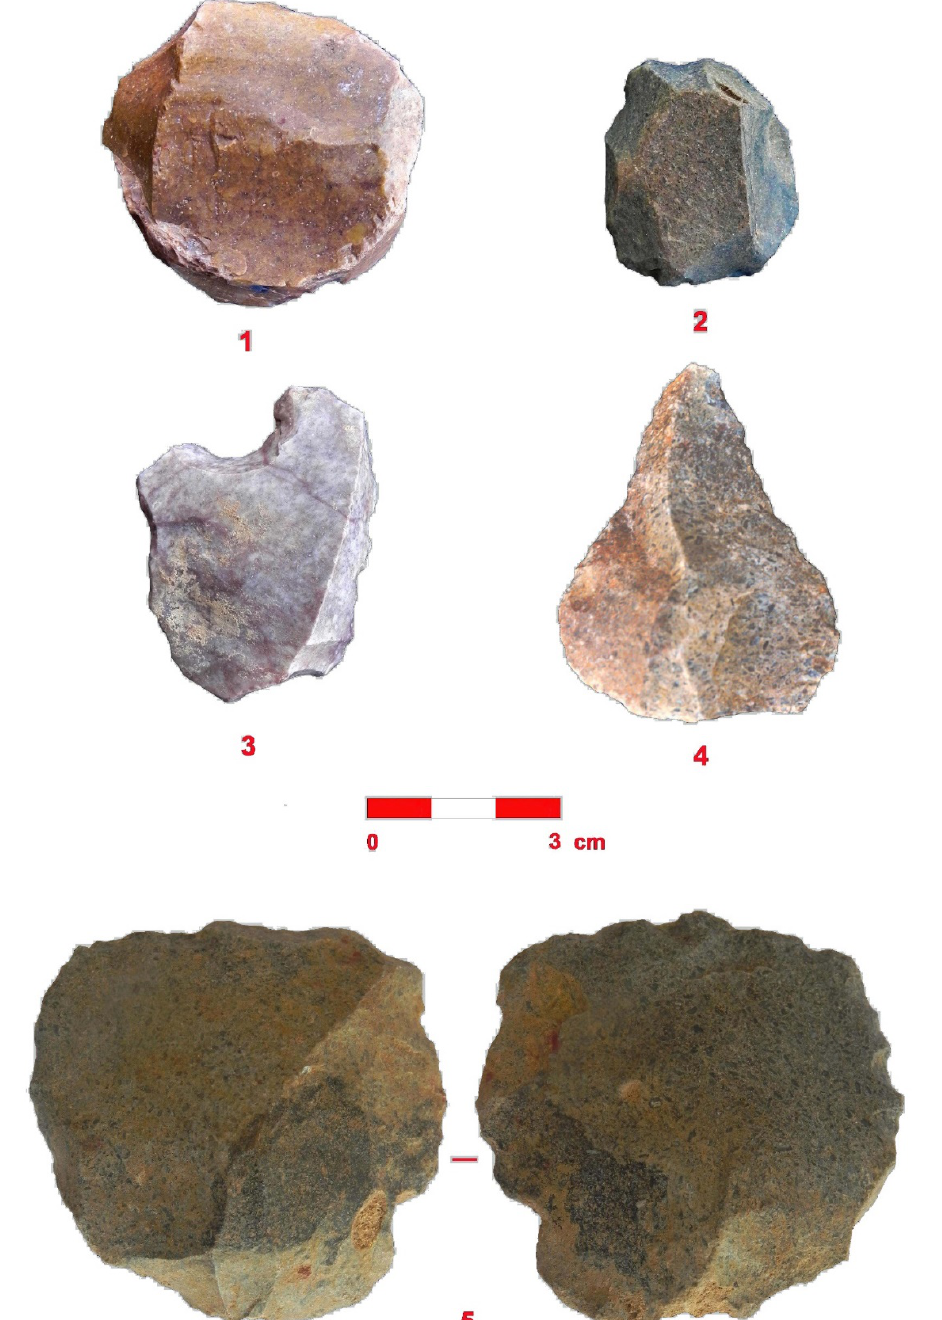
Figure 5. a Levallois core (1), a discoidal core (2), a denticulate and notch (3), a point (4) and an end-scraper with semi-circular front (5). All artifacts made on